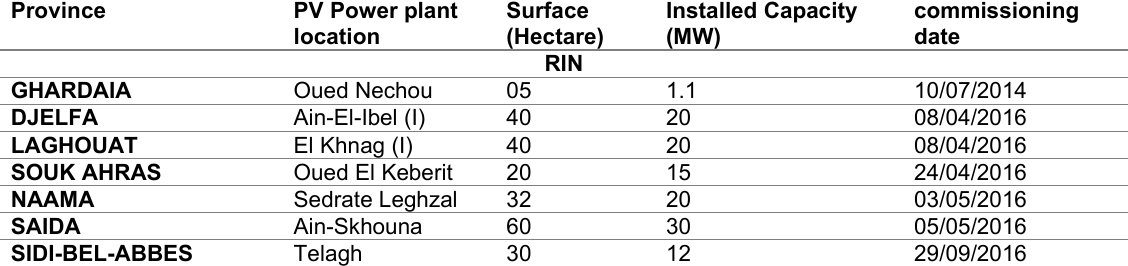
Table 3. PV solar energy